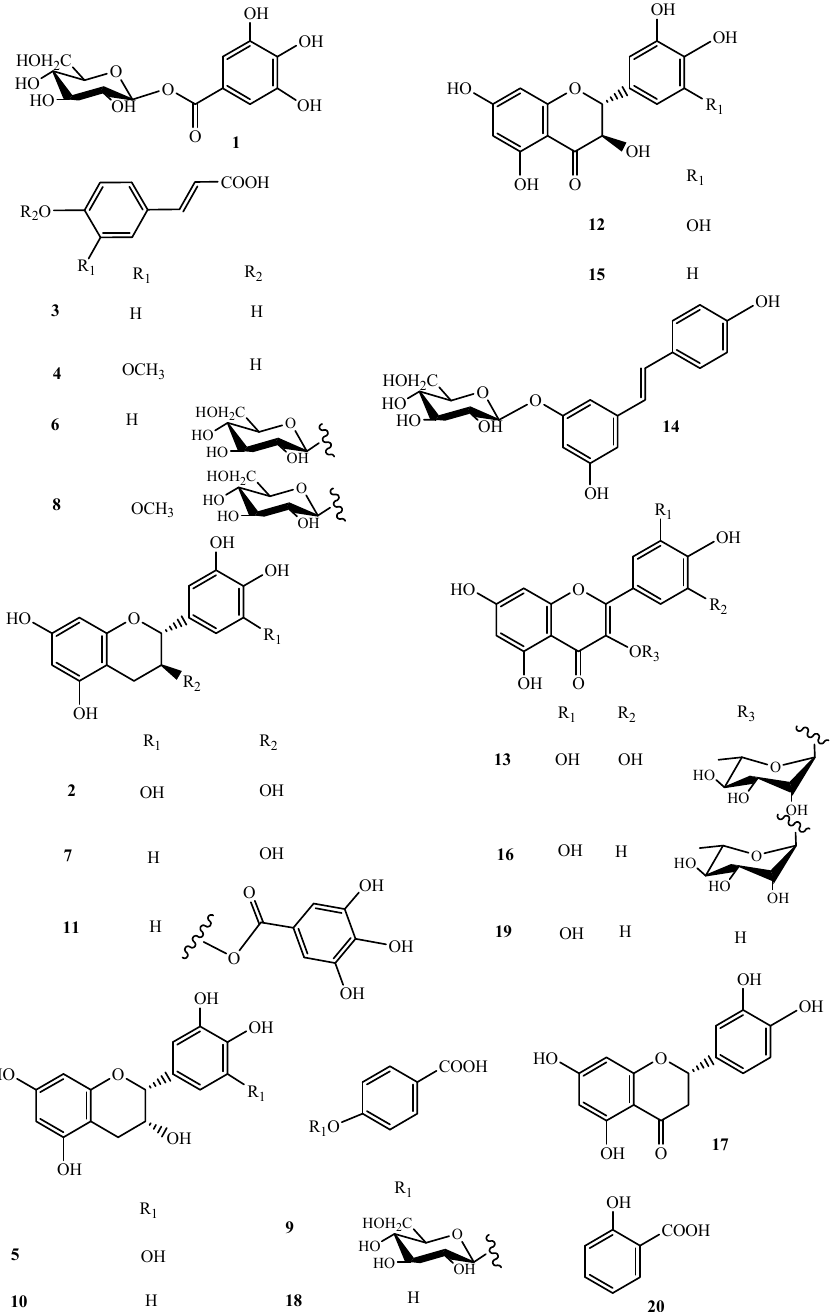
Figure 2. Compounds isolated from P. lucuma pulp n -BuOH extract .